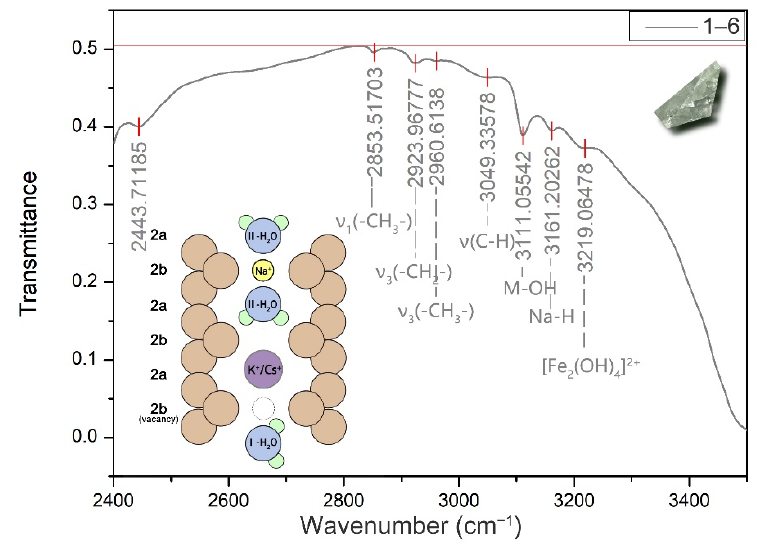
Figure 6. IR transmittance spectrum at 2400–3500 cm − 1 , including assigned peaks and a diagram of the structure of beryl.